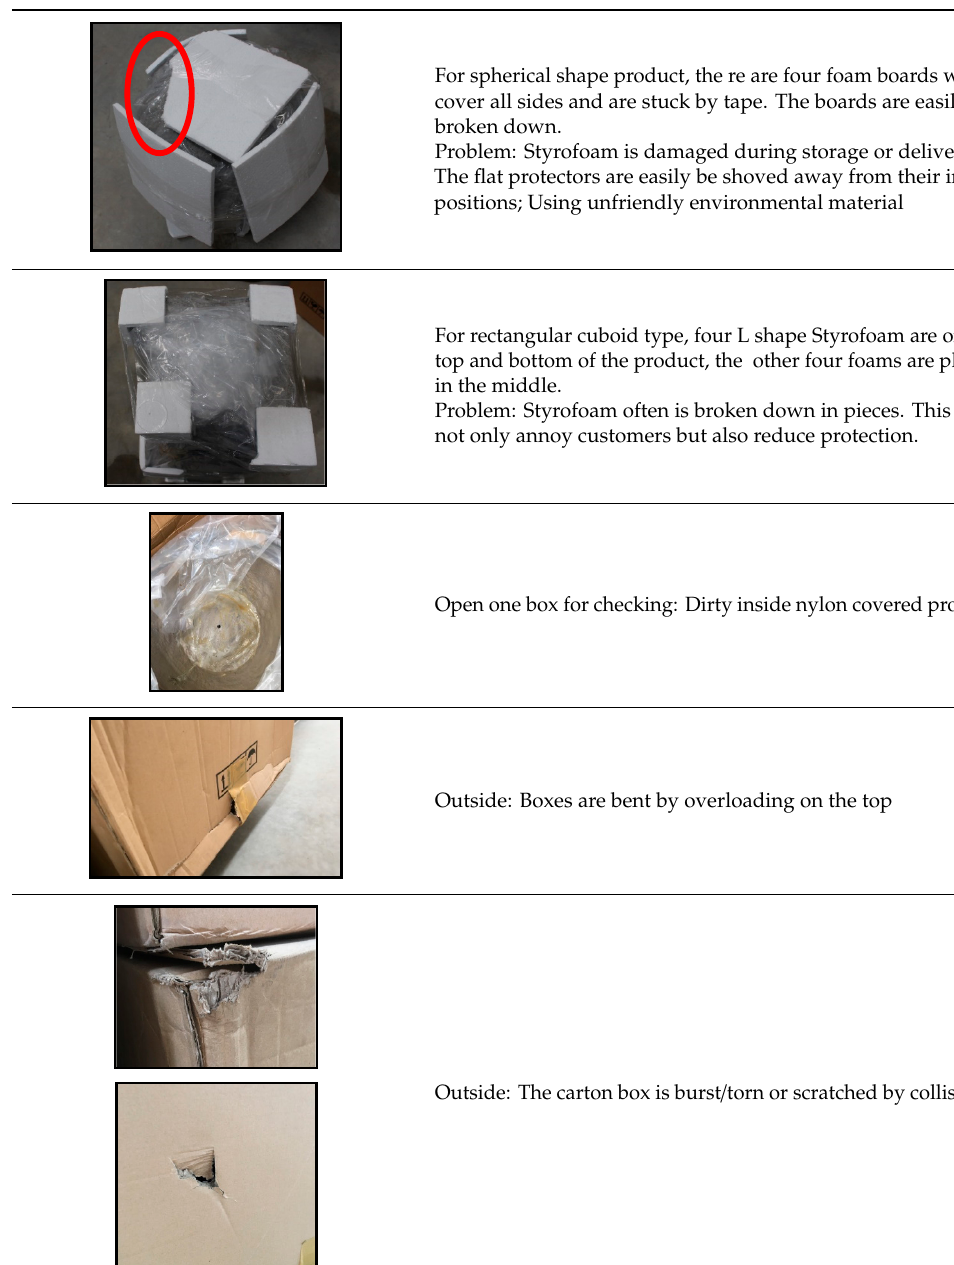
Outside: The carton box is burst/torn or scratched by collisions.